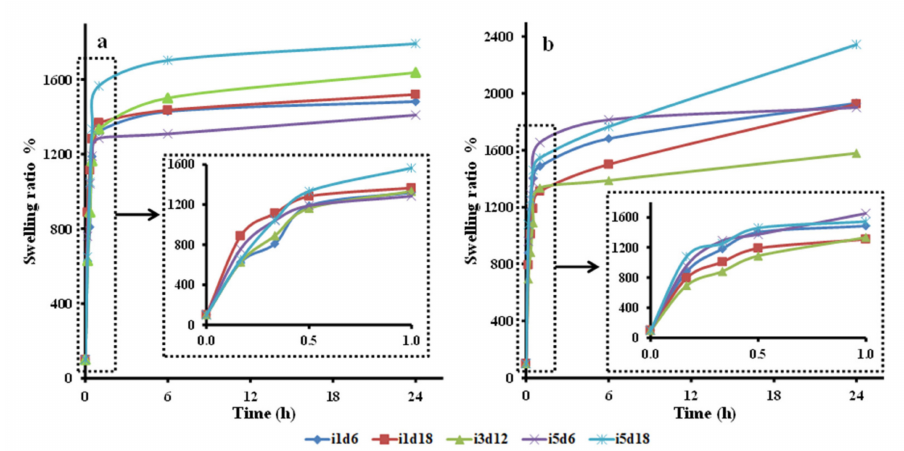
Figure 4. Swelling ratio of dry and moist bacterial cellulose (BC) membranes over 24 h. ( a )—moist BC membrane; ( b )—dry BC membrane; i—inoculum, d—harvest day; the number following “i” stands for inoculum volume 1, 3, 5 mL and the number following “d” represents the harvest day 6, 12, 18